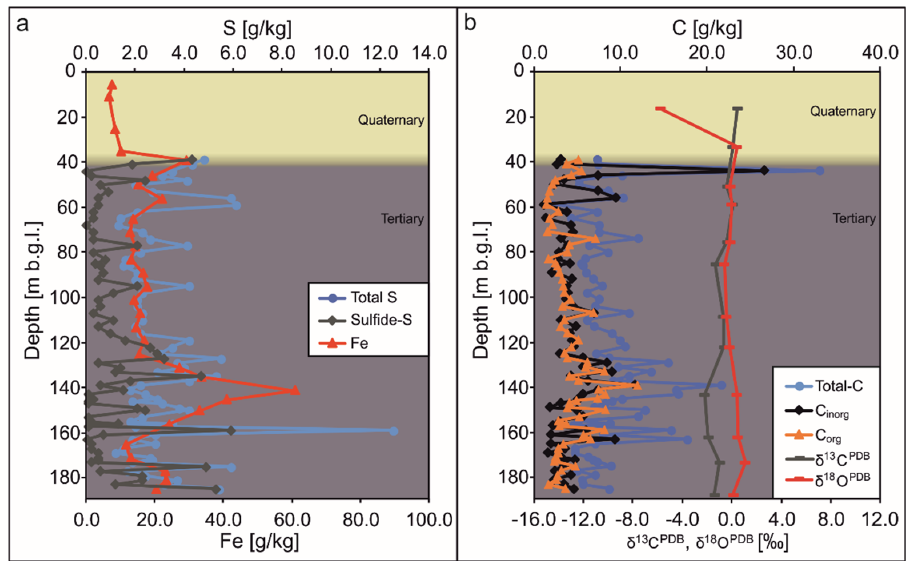
Figure 2. Sediment contents of the Quaternary–Tertiary aquifer. ( a ) S tot , S sulf , and Fe content. ( b ) C tot , C inorg , and C org content, and sediment isotope data of δ 13 C PDB and δ 18 O PDB .